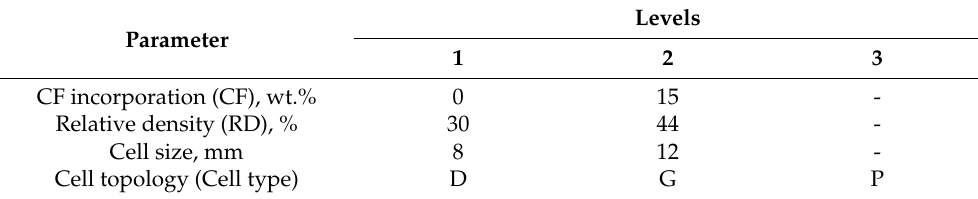
Table 2. Materials, design, and RD parameters and their levels.